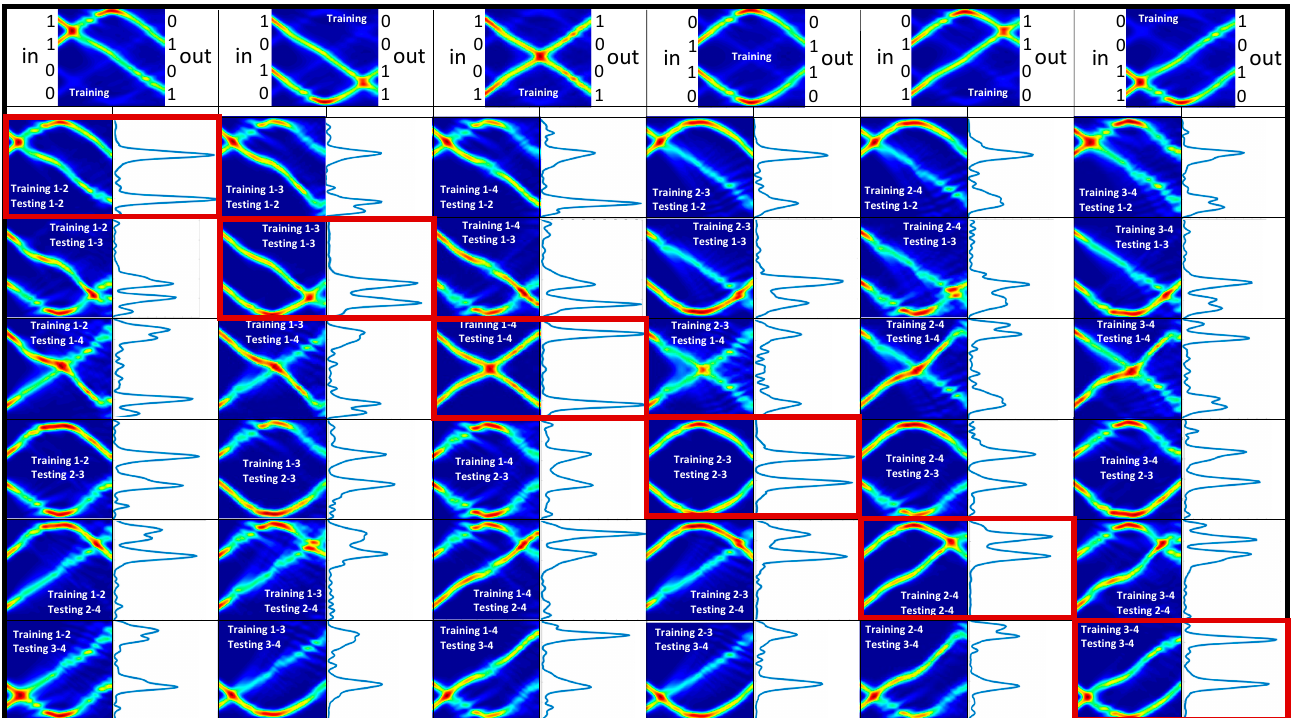
Figure 11. Training and testing phases are reported for 2 − digit, 4 − bit numbers. In the first raw, the training phases are reported. In the following raws, the testing experiments are reported. Those for which training and testing numbers coincide are framed in red.